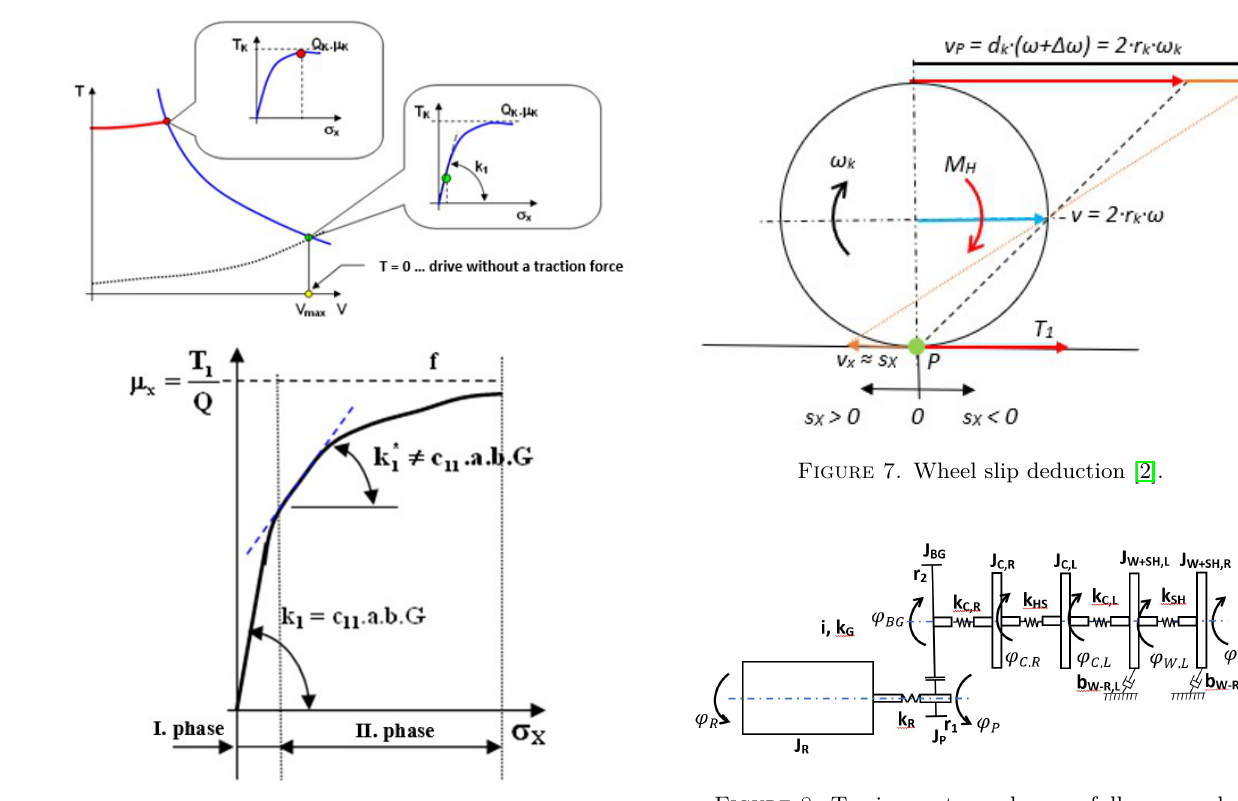
Figure 5. Traction characteristic and adhesion char- acteristic of wheelset [4–6].